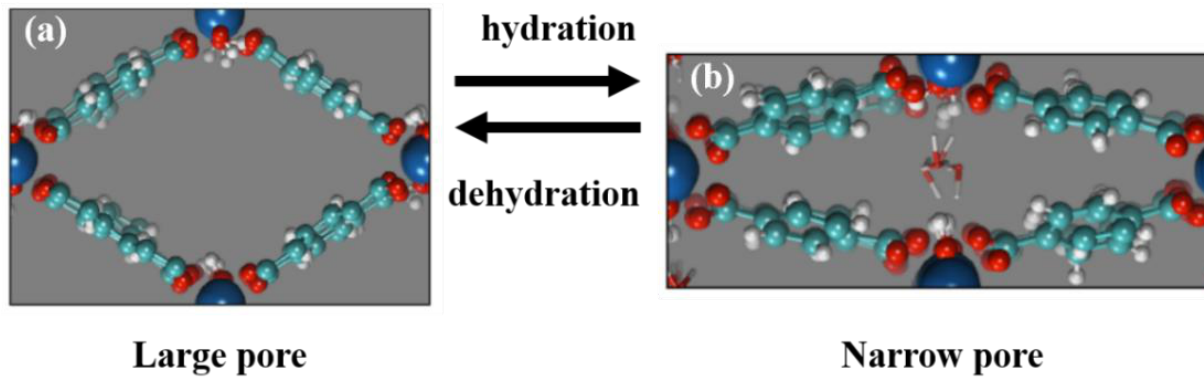
Figure 9. Illustration of the breathing behavior of MIL-53 using heat as the external stimulus. ( a ) dehydrated lp form; ( b ) hydrated np form. Reprinted with permission from [87]. Copyright 2013 American Chemical